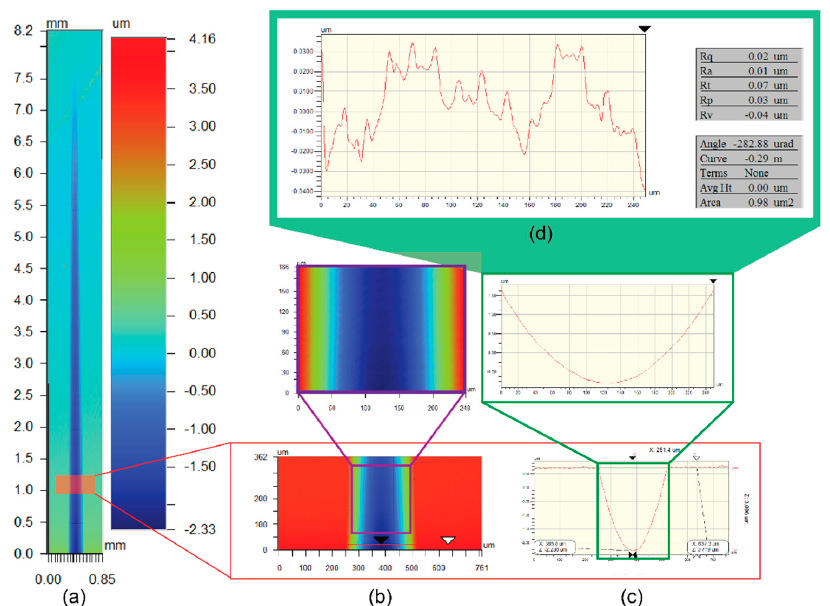
Figure 3. Surface data and the profile extraction of the taper cutting groove at a depth of cut (DoC) of 3 µ m. ( a ) Stitched surface profile from optical profiler; ( b ) a 2D profile; ( c ) a groove profile selected for analysis; ( d ) surface roughness measured by eliminating the groove curvature.